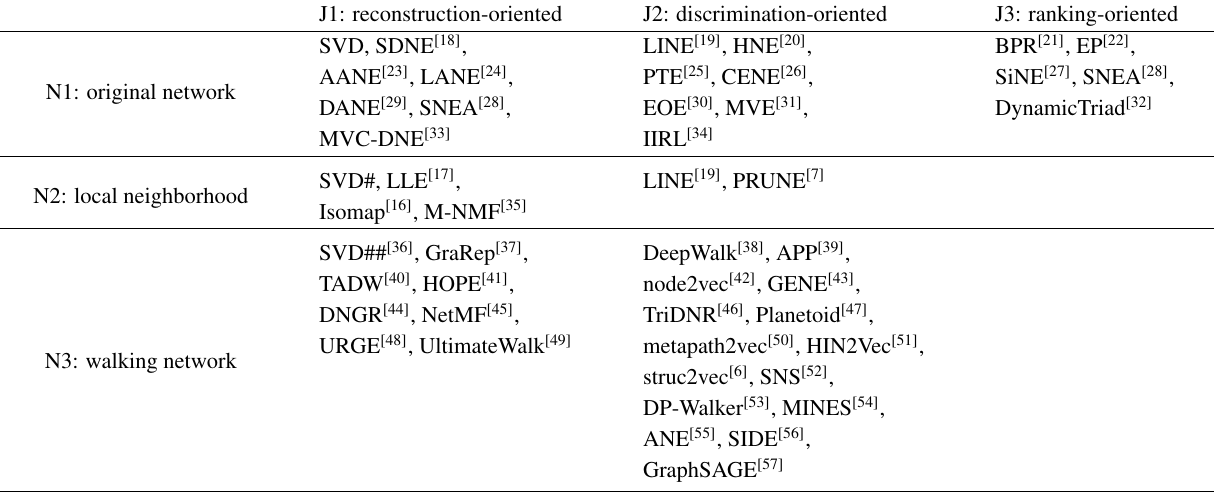
Table 1 A unified technical framework of network embedding